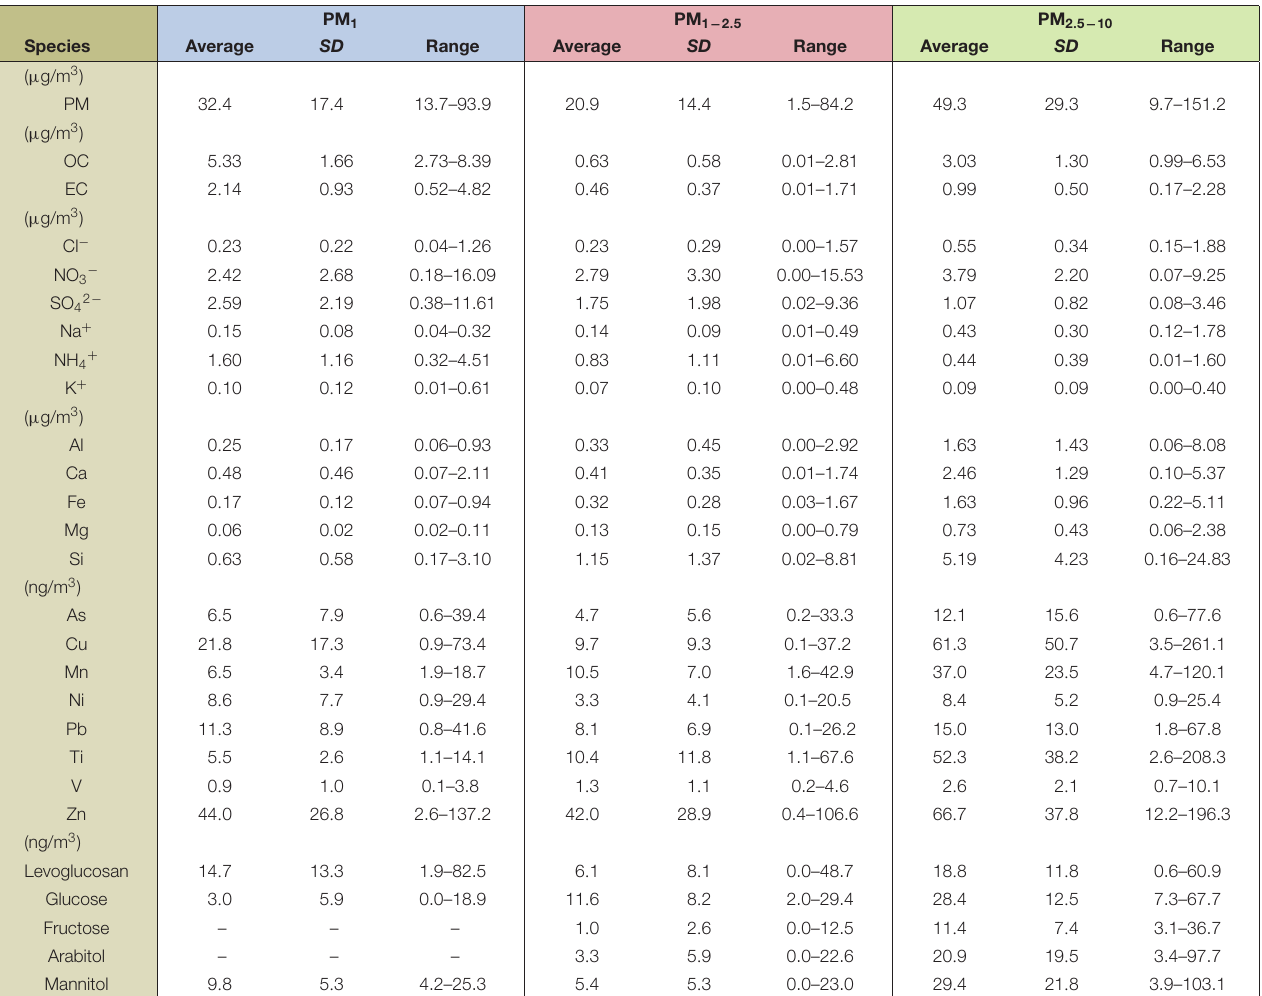
TABLE 1 | Statistical summary of the fraction-wise PM and its chemical